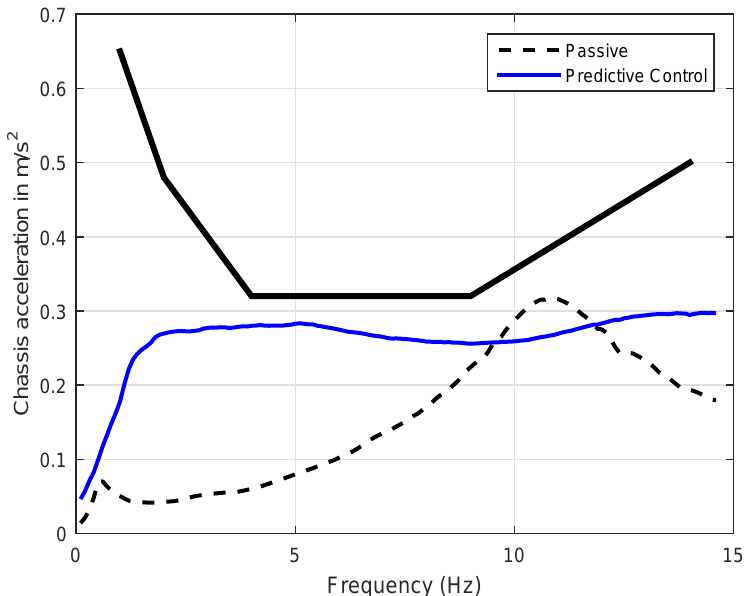
Figure 5. Chassis acceleration relation ¨ z s for the passive and predictive controller. Black line indicates the limit of the acceleration comfort.